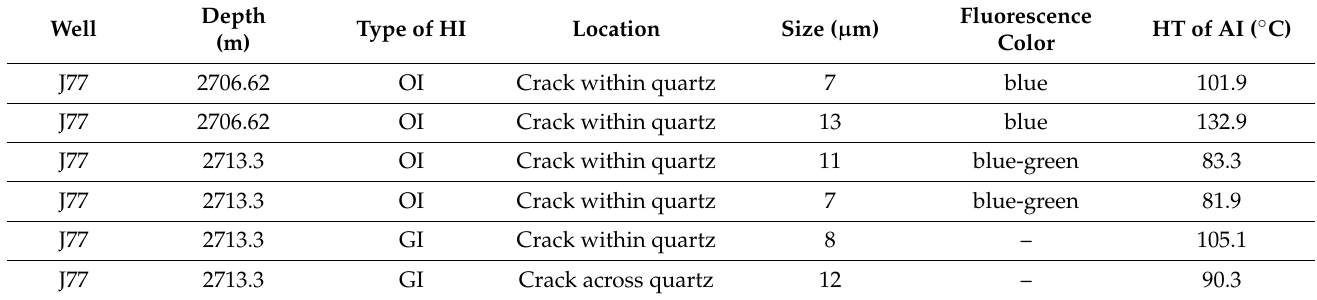
Figure 7. Histograms of homogenization temperatures of aqueous inclusions coexisting with hy- drocarbon inclusions from the sandstones in the Lower Shihezi Fm.